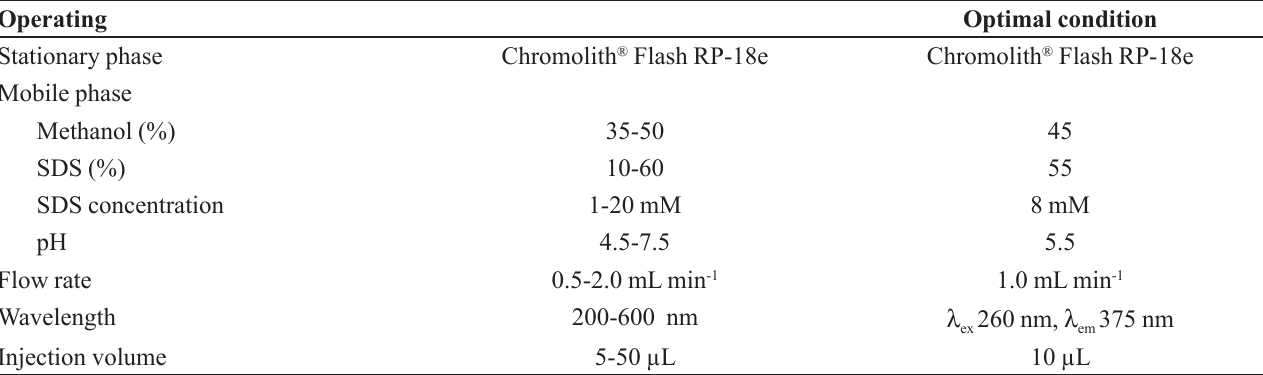
TABLE I - Optimized of isocratic IPLC condition for analysis of ketoconazole